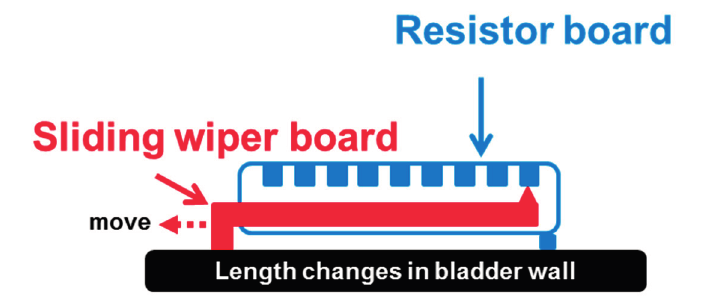
Figure 2. Conceptual drawing of the potentiometric module for detecting length changes in the bladder wall. The custom-made flexible potentiometer consisted of two fiberglass printed circuit boards (PCBs), including one board for potentiometric resistance that was soldered with resistors and the other board as a sliding wiper that contacted one of the resistors. The bladder capacity was predicted by the resistance